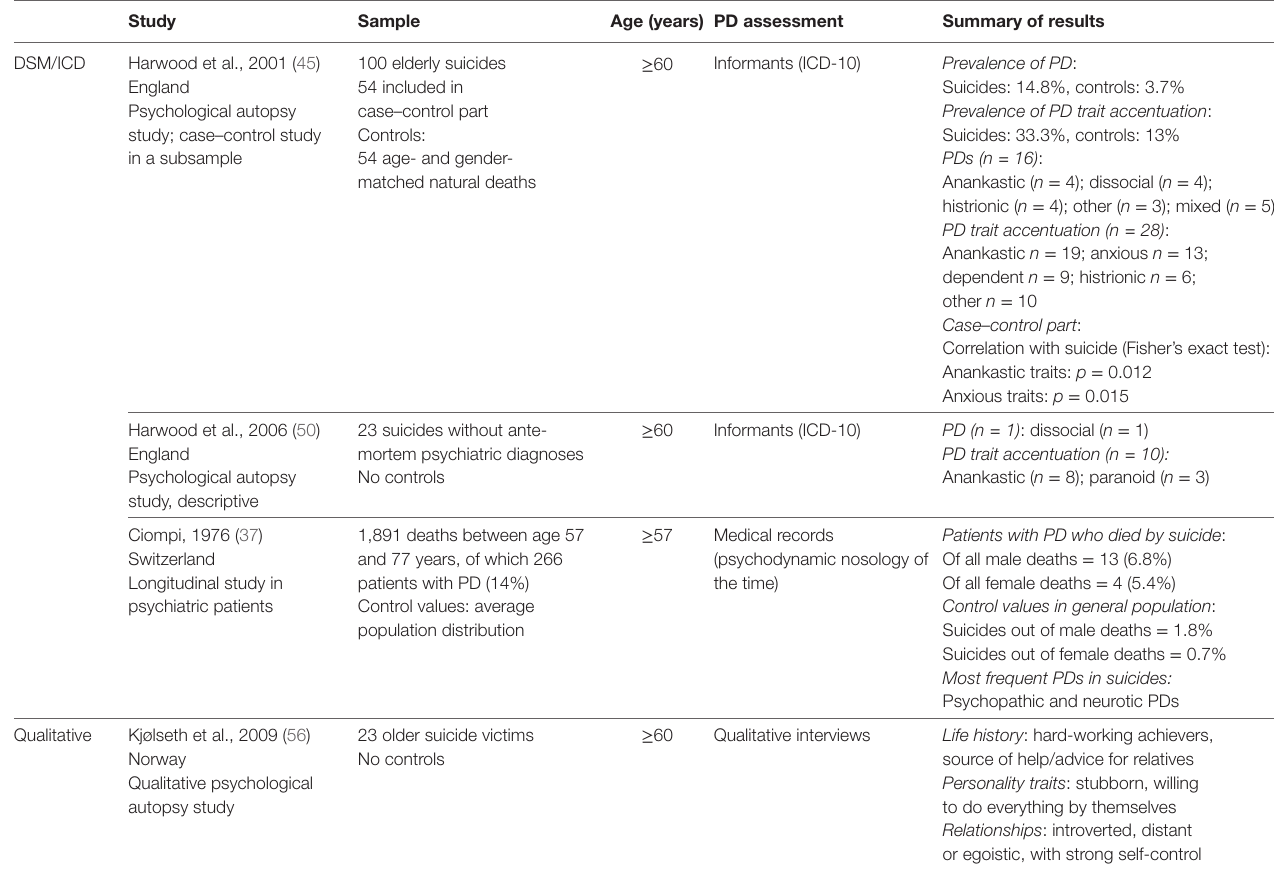
taBLe 2 | Categorical findings on separate personality disorder diagnoses in death by suicide, and qualitative findings. Study